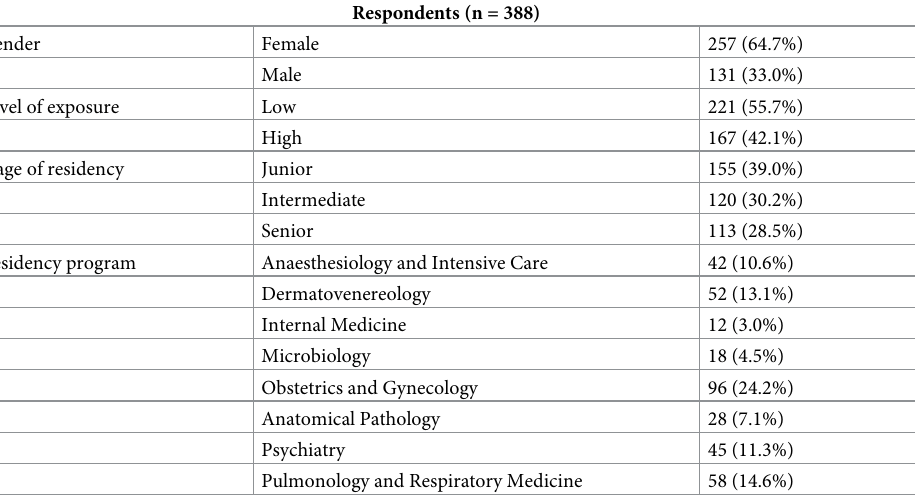
Table 1. Demographic data of respondents (n = 388